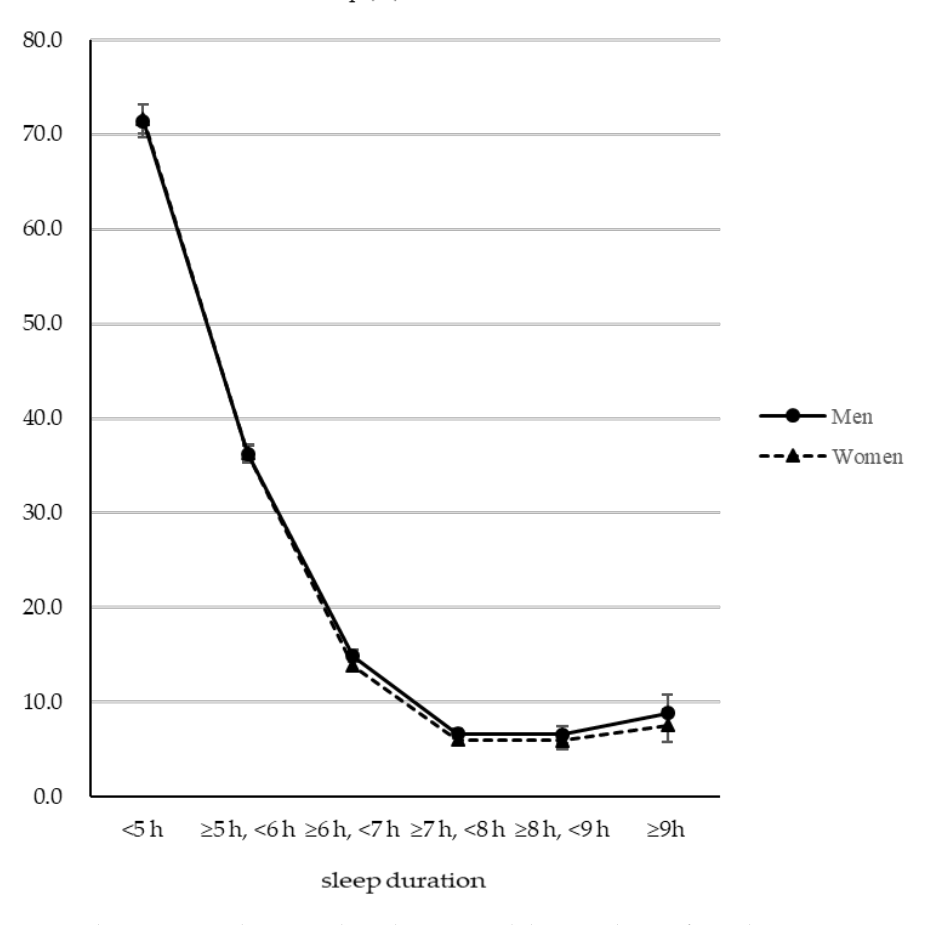
Figure 1. The association between sleep duration and the prevalence of NRS by sex. Table 3. Odds ratio of NRS for alcohol and smoking among